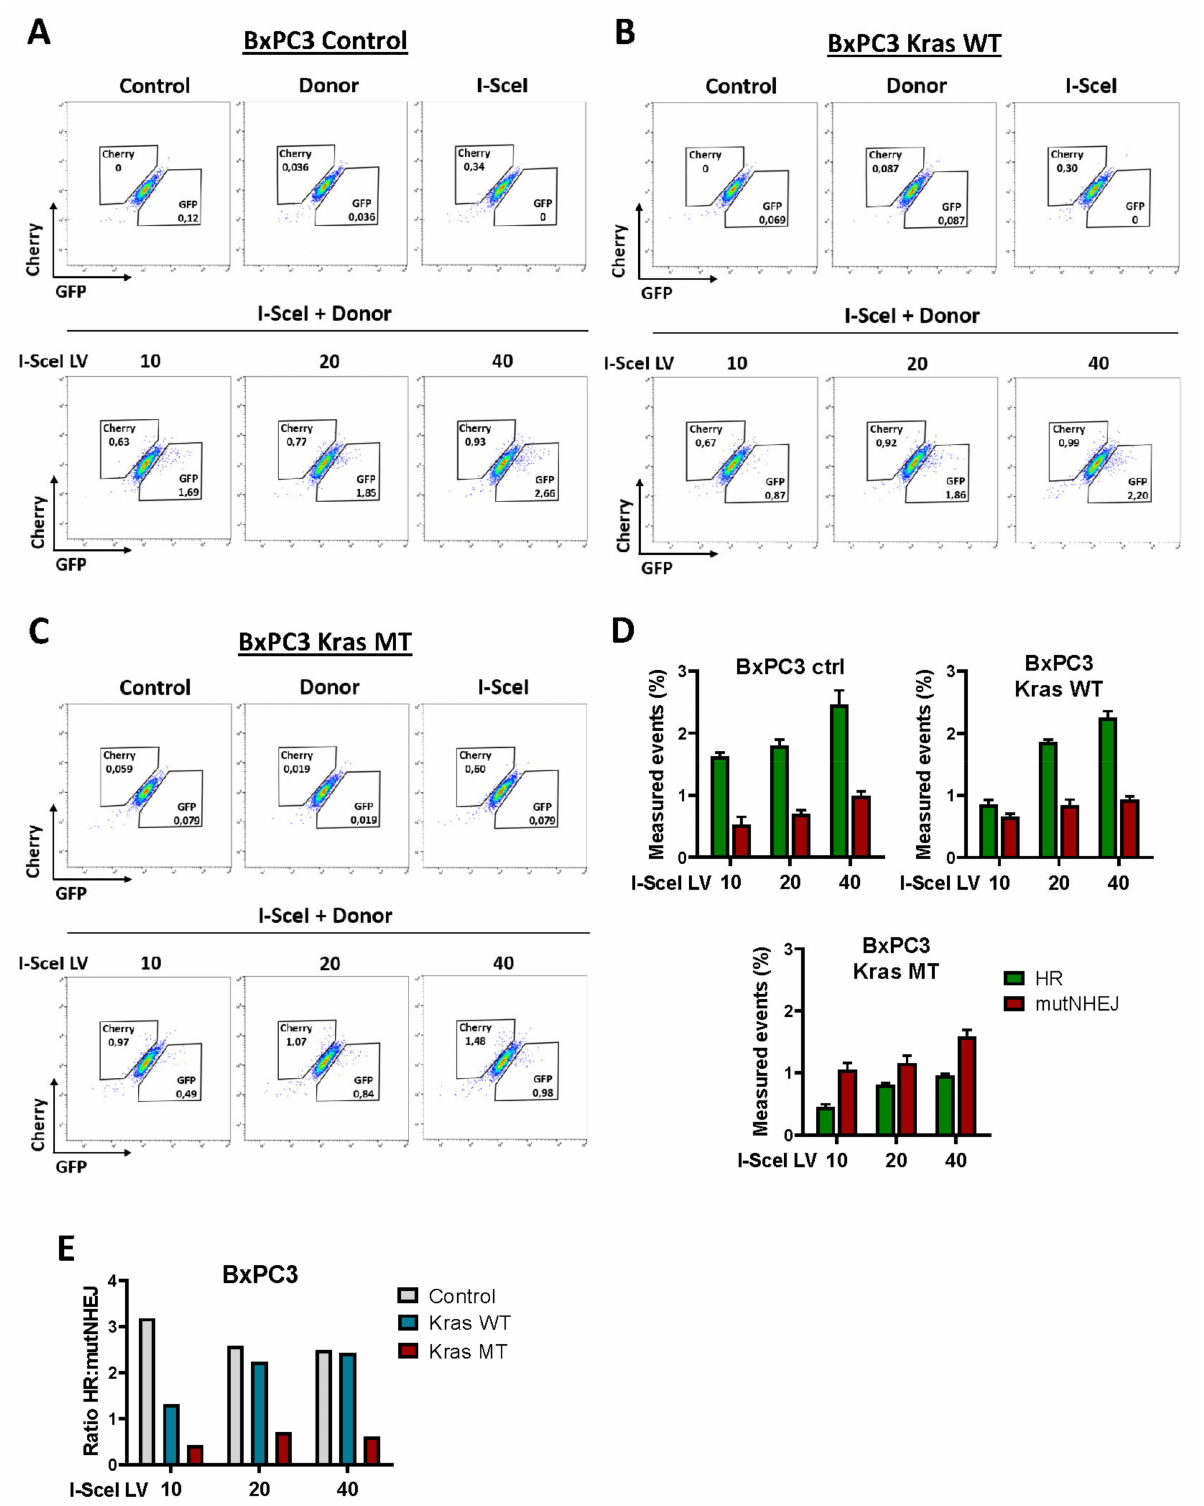
Figure 4. Traffic light reporter assessment of DNA repair fates in human pancreatic cancer cell lines. ( A – C ) Representative flow plots following transduction of BxPC3 cells with donor and different doses of I-SceI lentivirus (LV) from three independent experiments are shown. Cherry-positive cells indicate a repair event induced by mutNHEJ, and GFP-positive cells represent cells with the HR repair event. ( D ) Quantification of data from all variants of BxPC3 cells is presented. Error bars represent mean ± SD. ( E ) Ratio of HR to mutNHEJ based on data in panel